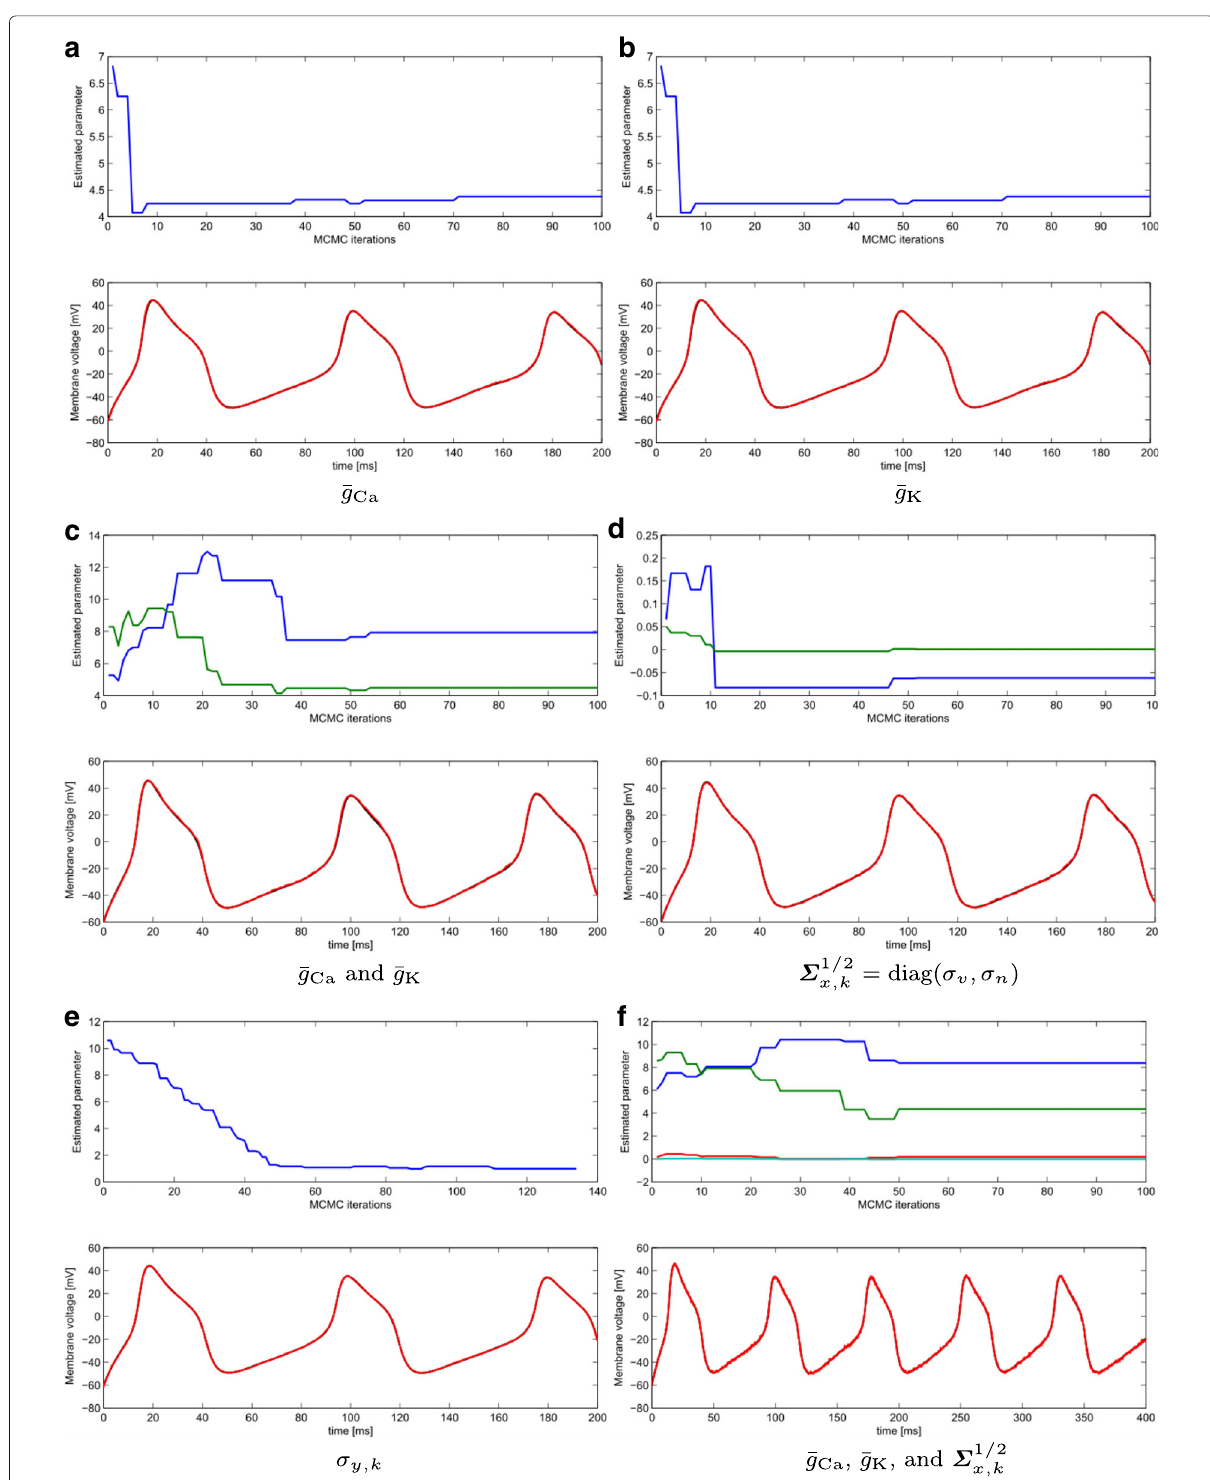
Fig. 5 Realizations of the PMCMC algorithm for joint state-parameter estimation. Each panel corresponds to different unknown parameters, see Table 2. Particularly, we show the results when estimating ( a ) Calcium maximal conductance, ( b ) Potassium maximal conductance, ( c ) both Calcium and Potassium maximal conductances, ( d ) process noise variance, ( e ) measurement noise variance, and ( f ) Calcium and Potassium maximal conductances plus process noise variance. Each panel features the MCMC iterations (top) that converge to the true value of the parameter and the filtered voltage trace